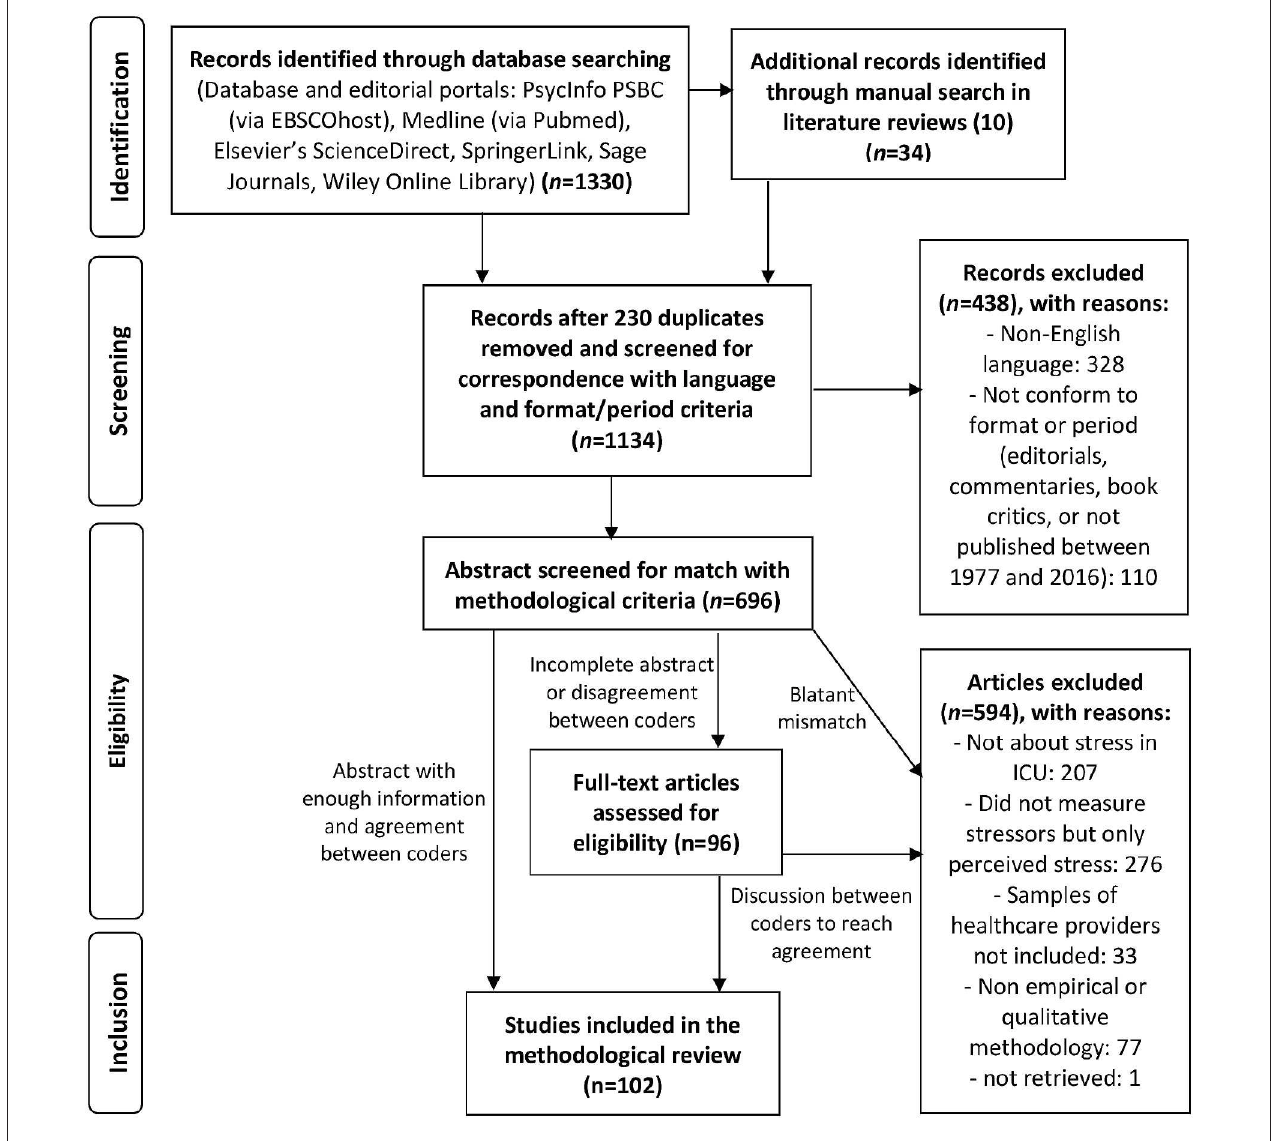
FIGURE 1 | Flow diagram of selected articles based on relevance search